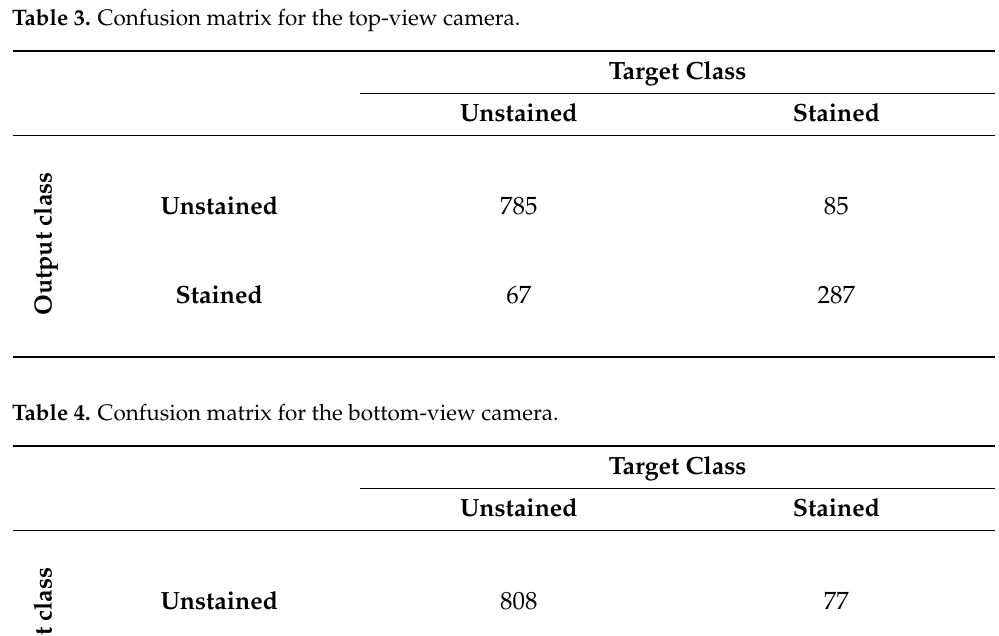
10 of 14 Figure 7. Confusion matrix of the cocoon-shape-selection procedure based on the logistic regres- sion model as described in Section 2.3 (Class 1 stands for well-shaped cocoons; Class 2 stands for bad-shaped cocoons).